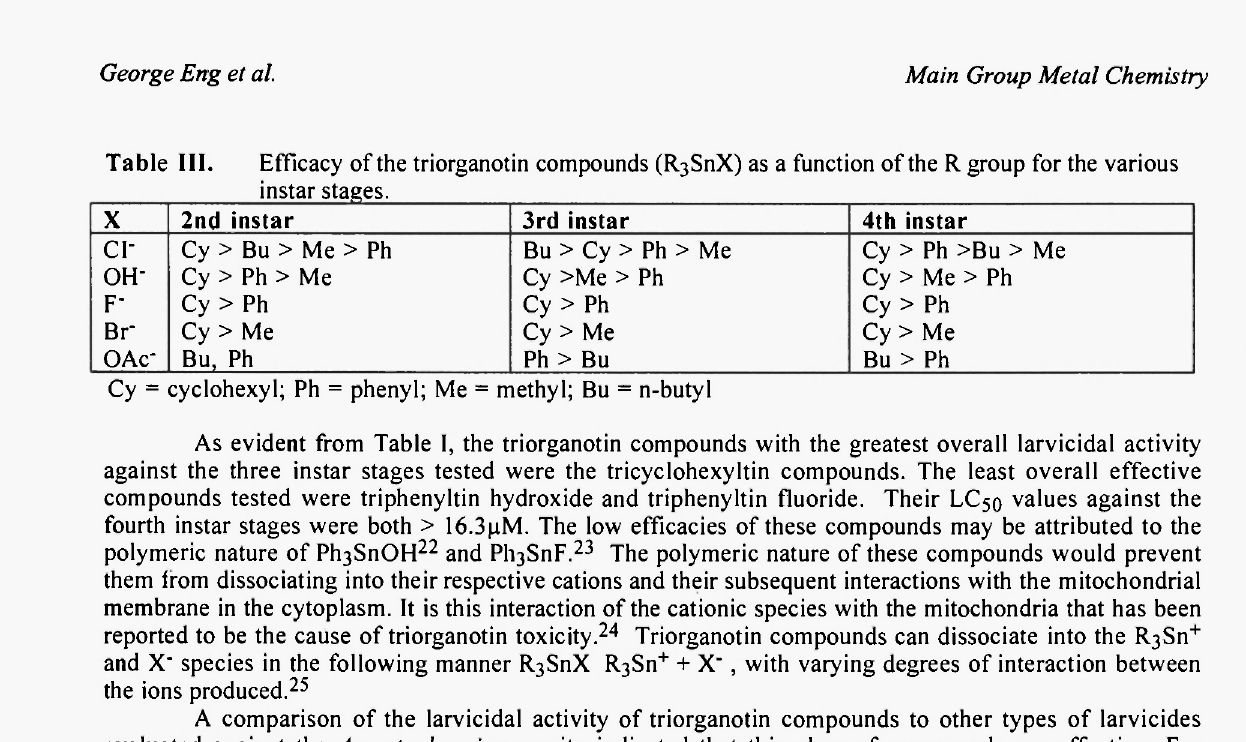
Table III. Efficacy of the triorganotin compounds (R^SnX) as a function of the R group for the various instar